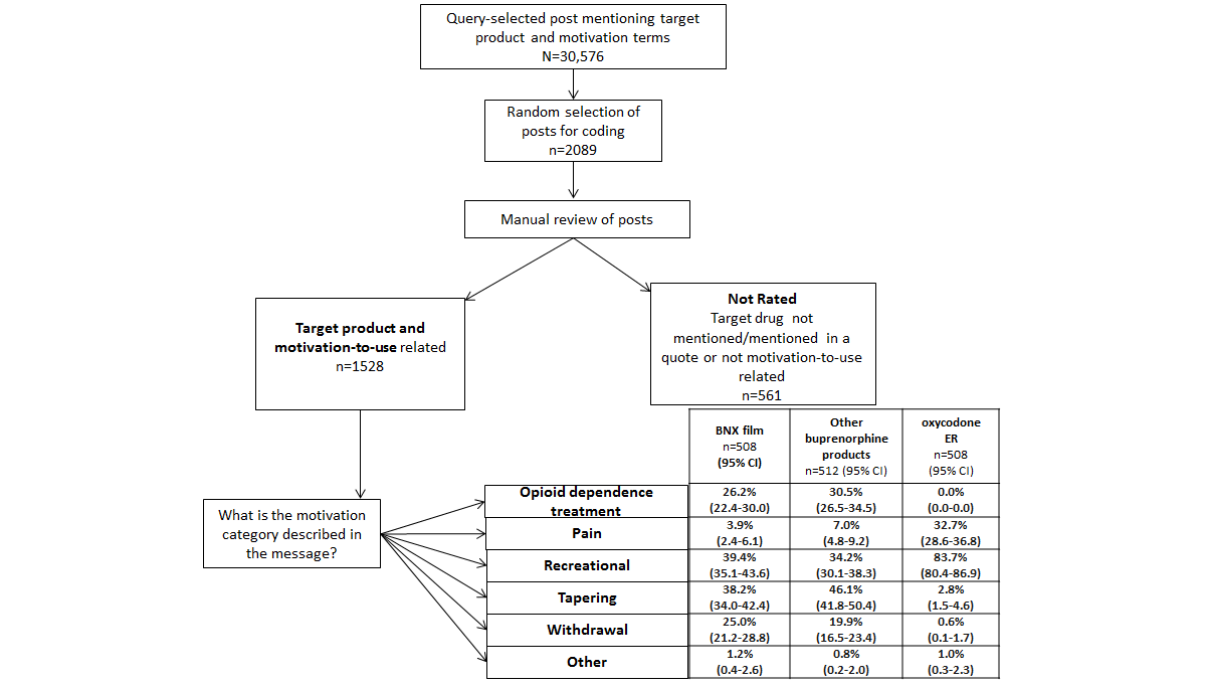
Figure 1. Motivation-to-use content analysis flow chart. BNX: buprenorphine/naloxone; ER: